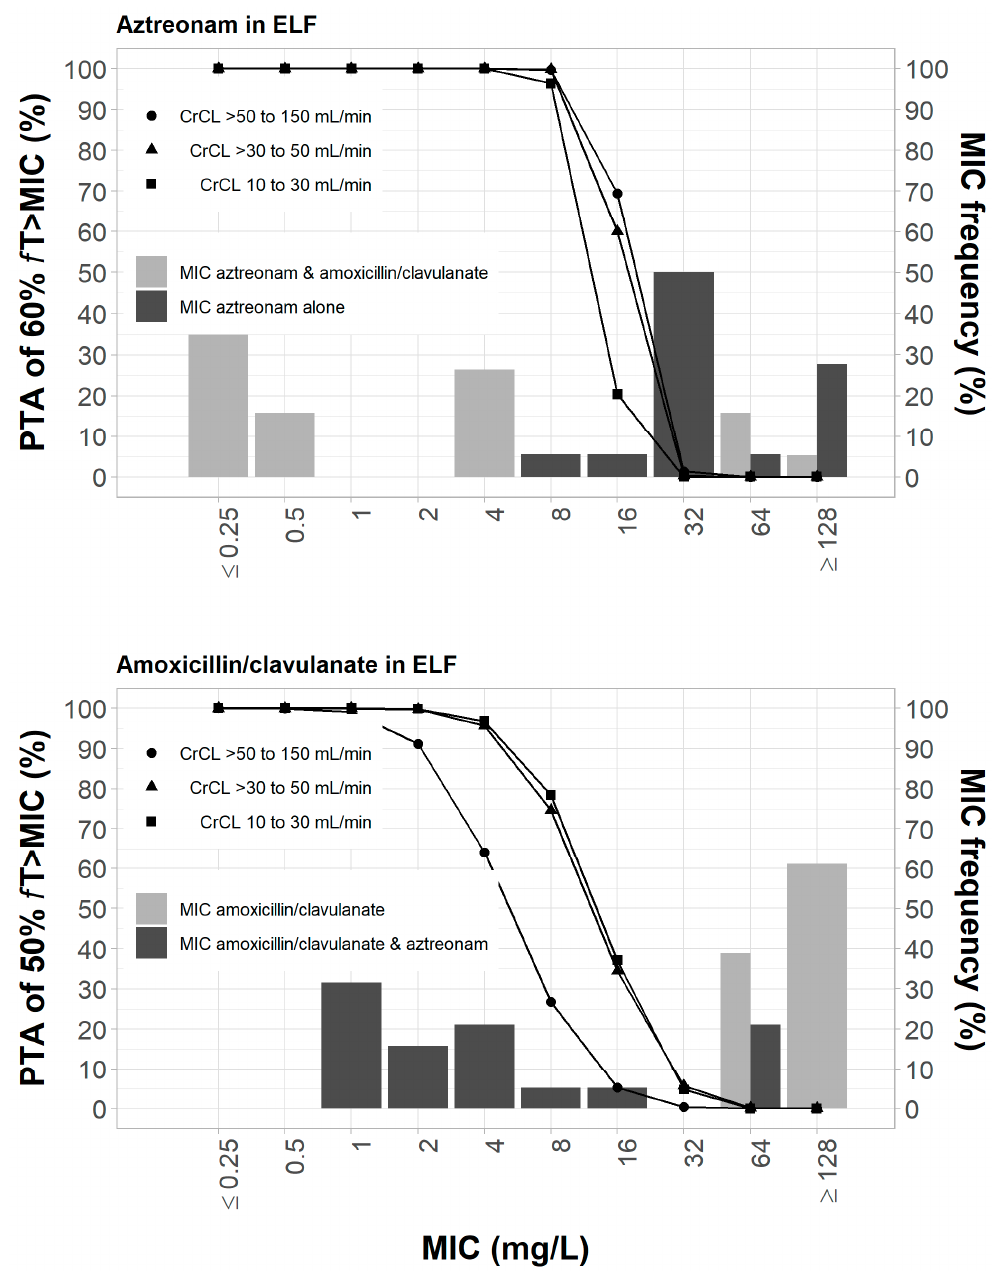
Figure 3. Probability of target attainment of 60% f T >MIC and 50% f T >MIC for aztreonam and amoxicillin/clavulanate dosing regimens by renal function category, respectively, listed in Table 1. Probability of target attainment values were computed based on steady-state drug concentrations in the epithelial lining fluid and their respective epithelial lining fluid penetration.